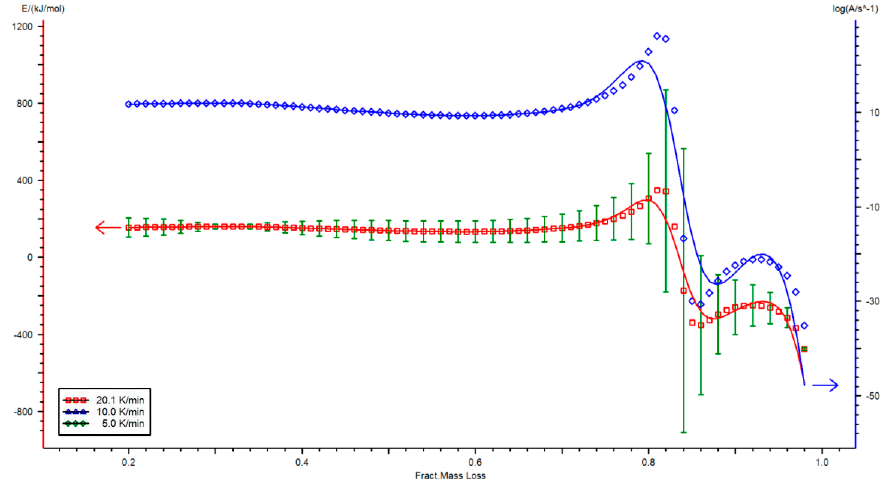
Figure A5. Activation energy and pre-exponential coe ffi cient as a function of the degree of conversion